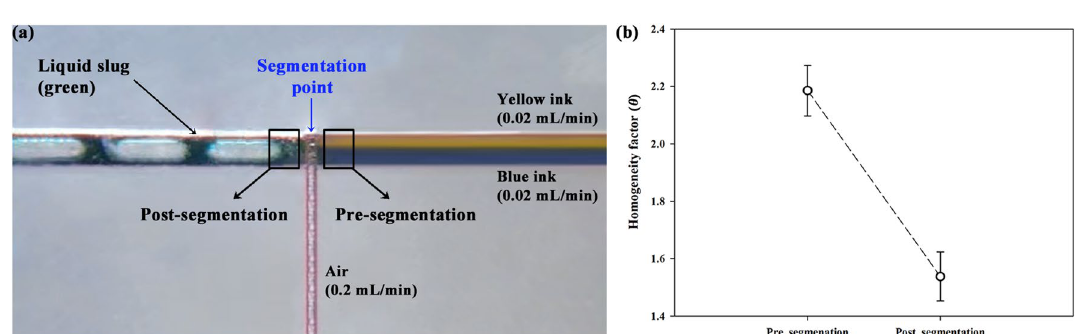
Figure 7. ( a ) Void fraction ( L B /( L S + L B )) depending on gas volumetric quality ( j G /( j G + j L )) (y 0 = 0.0153, a = 0.9850). ( b ) The length of liquid slug ( L S ) with capillary number ( Ca ) (y 0 = 280.6407, a = 4295.0156, b = 6.1407 × 10 –5 ).